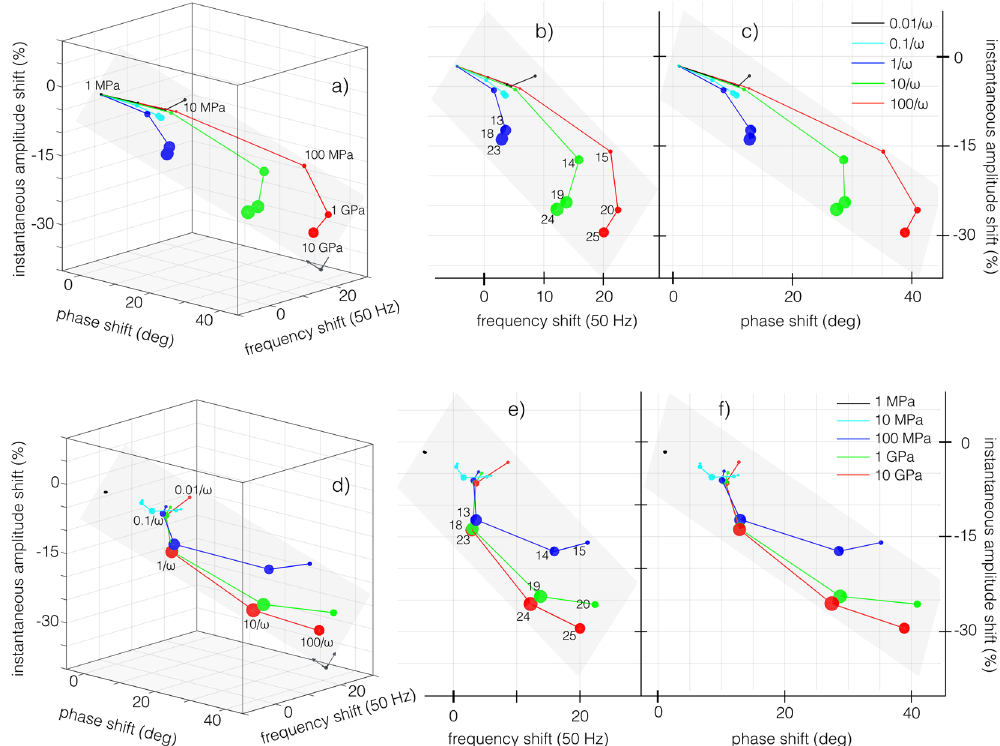
Figure 5. 3D representations, ( a , d ), and projections, ( b , c , e , f ), of the shifts of the instantaneous parameters (frequency, phase and amplitude), with respect to the free cantilever, when the tip impacts on surfaces with different viscoelastic properties. The marker sizes are proportional to the calculated tip-sample dissipation. The points in ( a and d ) lay on a plane whose normal is orthogonal to the page. In ( a – c ) the retardation times are mapped with different colors, with the glassy modulus increasing from the origin outwards (as in the numbered sequence in panel (a)). In ( d – f ) the glassy moduli are mapped with different colors, with the retardation times increasing from the origin outwards (as in the numbered sequence in panel (d)). The numbers reported in ( b and e ) refer to the materials numbers highlighted in gray in Fig. coordinate axis. This fact shows that amplitude, phase and frequency are not independent and constrained to remain on a plane as the change in the viscoelastic parameters affects the dynamical conditions of the motion. To understand how the material properties are captured by the wavelet analysis, and how it is possible to asso- ciate a measurement to a set of viscoelastic properties, we first explain the main blocks of our analysis. Figure 6(a)